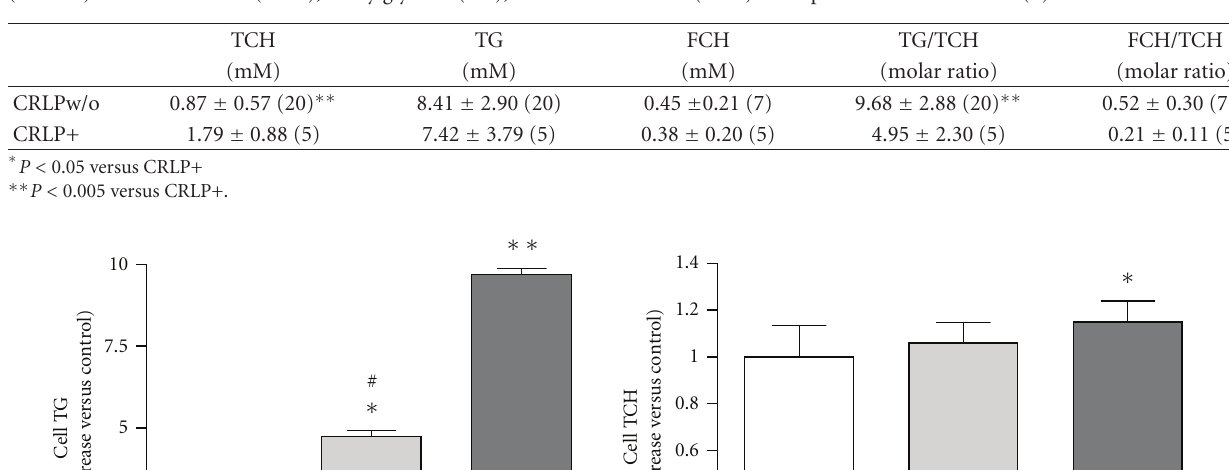
Table 1: Biochemical characterization of chylomicron remnant-like lipid particles (CRLP) incubated without (CRLPw/o) or with plasma (CRLP+). Total cholesterol (TCH), triacylglycerol (TG), and free cholesterol (FCH) are expressed as means ± SD ( n ).